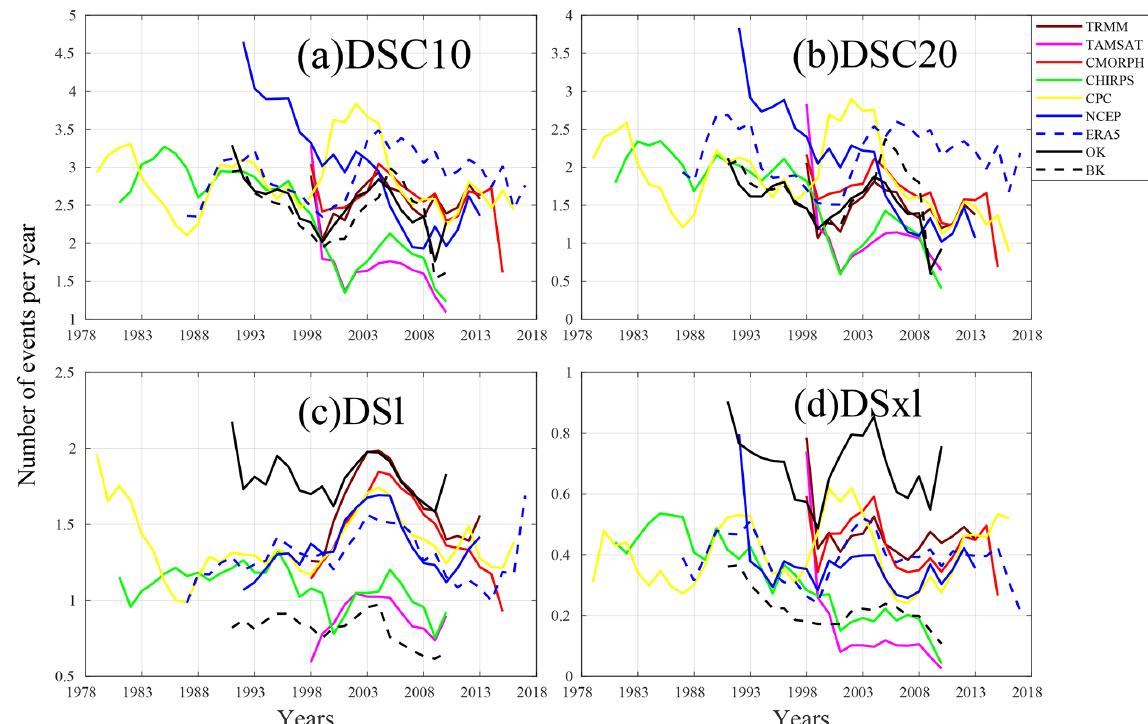
Figure 9. Inter-annual variability in average numbers on all grid points of DSC10, DSC20, DSl, and DSxl computed over the period of availability for each dataset: TRMM (1998–2013), TAMSAT (1998–2010), CMORPH (1998–2015), CHIRPS (1981–2010), CPC (1979– 2016), NCEP (1992–2013), ERA5 (1987–2017), BK (1991–2010), and OK (1991–2010). Details on the datasets and dry spells are provided in Tables 1 and 2,